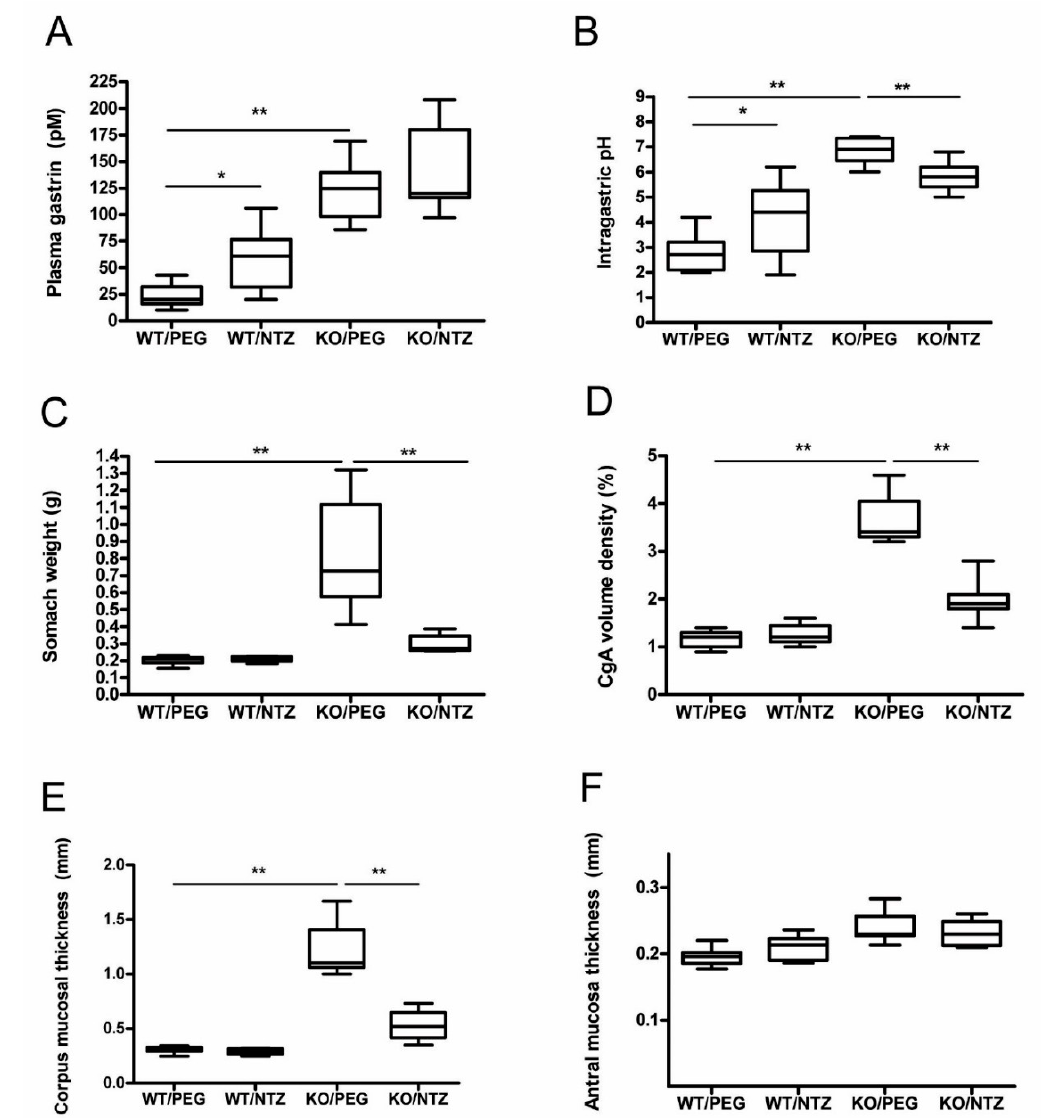
Figure 1. Intragastric pH ( A ), plasma gastrin ( B ), stomach weight at termination ( C ), chromogranin A (CgA) volume density ( D ), corpus ( E ) and antral ( F ) mucosal thickness in H + /K + ATPase beta subunit knockout (KO) mice and wild-type (WT) controls given netazepide (NTZ) or polyethylene glycol (PEG) as vehicle.